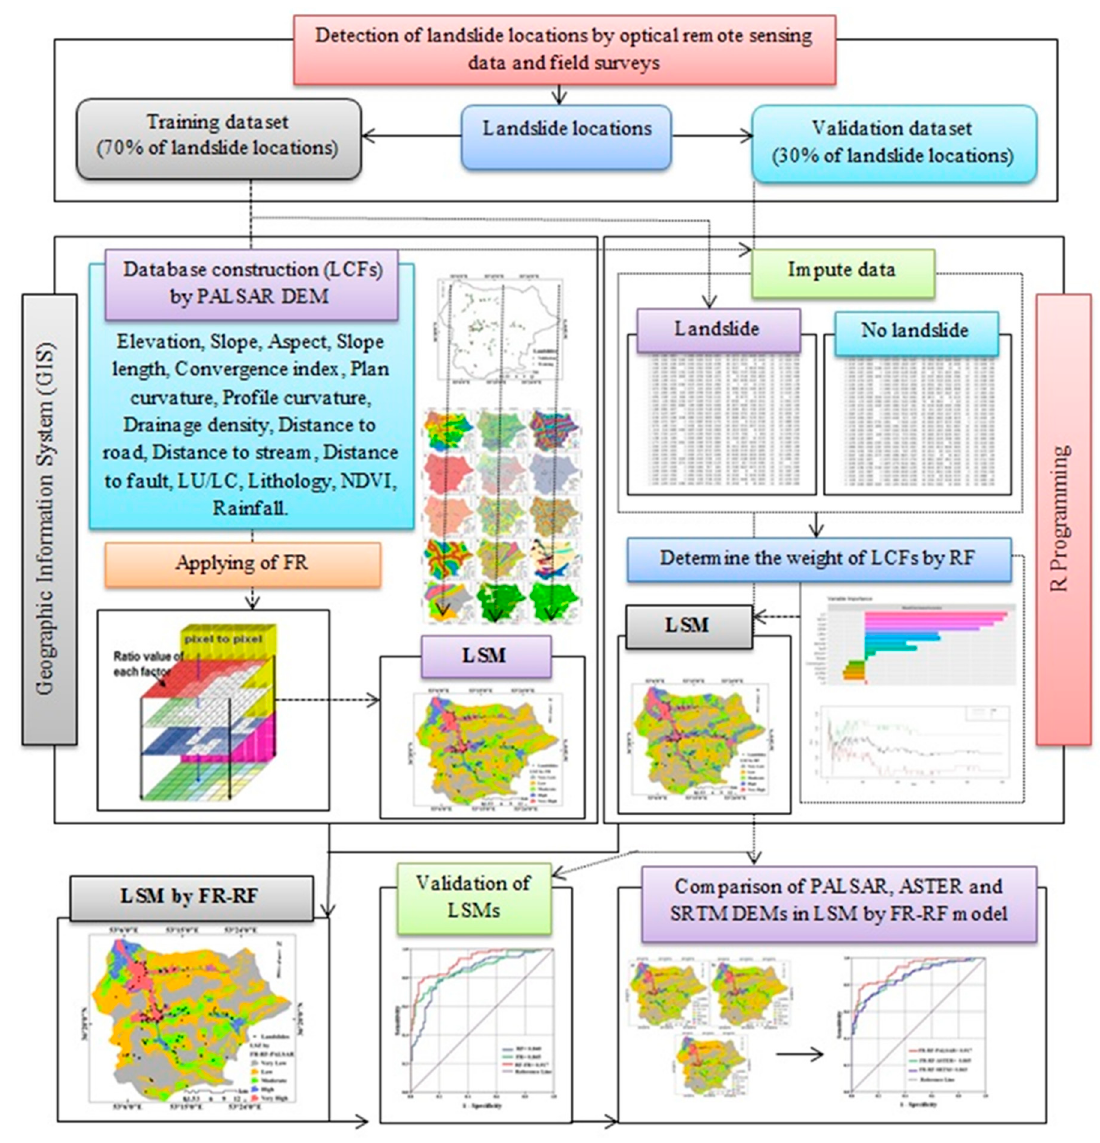
Figure 3. Methodological flowchart.